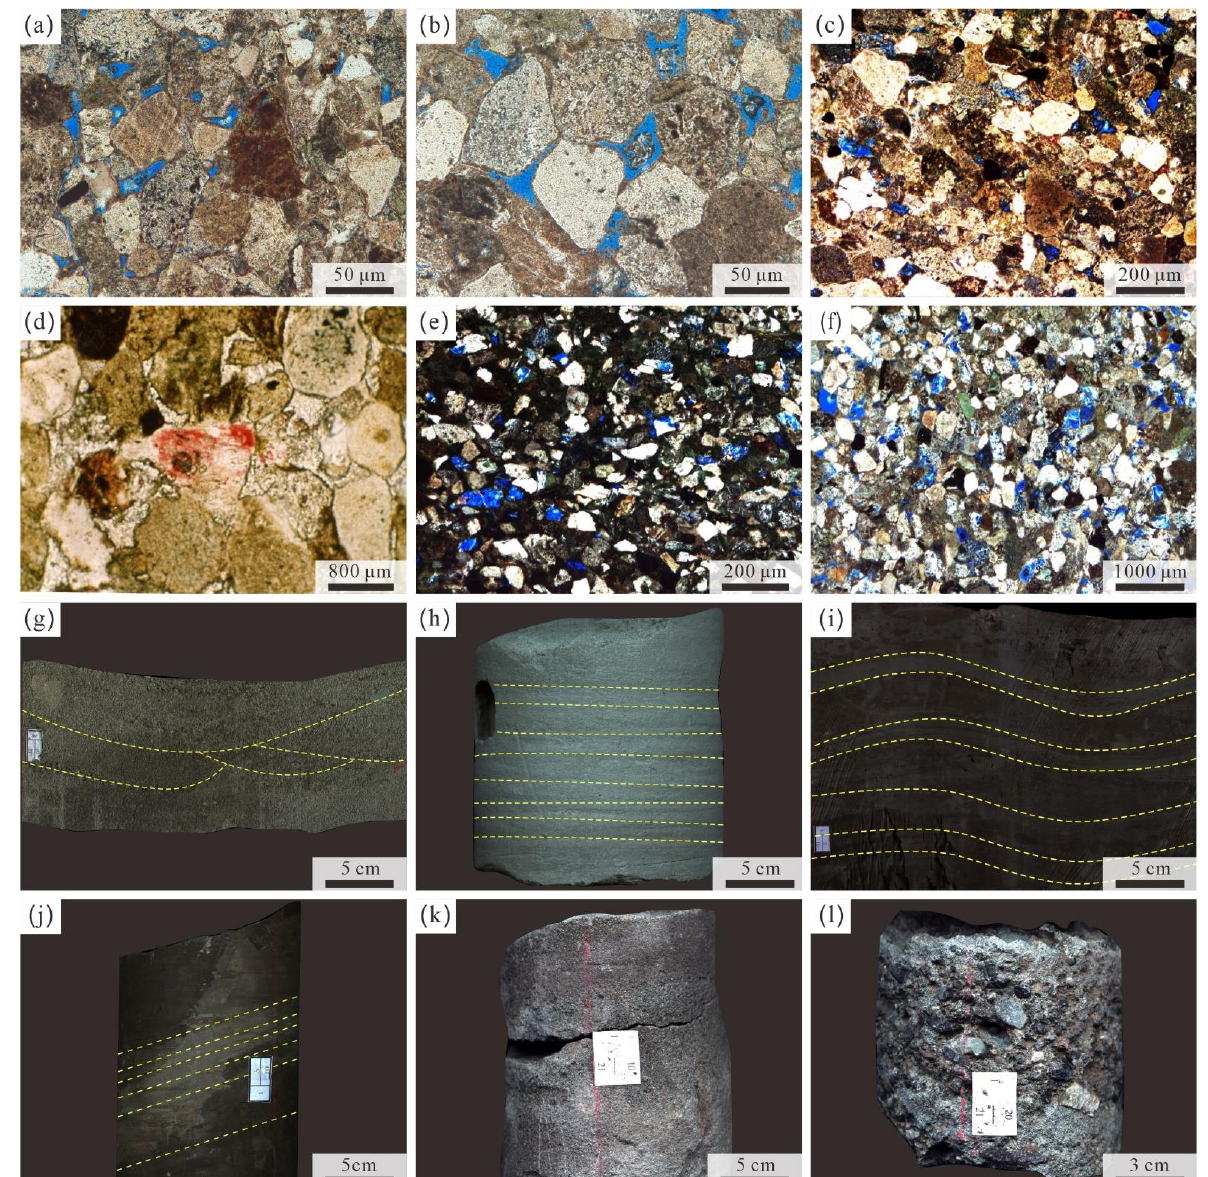
Figure 2. Rock characteristics of the Jiucaiyuan Formation in the Beisantai Uplift. ( a ) Well-sorted medium-grained sandstone with subangular particles; Drillcore SZ-2, 3415.88 m, Member II; PPL. ( b ) Gravelly medium-grained sandstone with medium sorting and subangular to subrounded par- ticles; Drillcore SZ-2, 3416.97 m, Member II; PPL. ( c ) Poorly-sorted medium-grained sandstone with subrounded particles; Drillcore GV-5, 2091.56 m, Member II; PPL. ( d ) Fine-grained sandstone with medium sorting and angular to subangular particles; Drillcore DB-2, 2372.70 m, Member II; PPL. ( e ) Well-sorted very fine-grained sandstone with subrounded particles; Drillcore EJ-6, 2600.35 m, Member I; PPL. ( f ) Well-sorted very fine-grained sandstone with subrounded particles; Drillcore EJ-6, 2600.68 m, Member I; PPL. ( g ) Brown sandstone with trough cross bedding; Drillcore NH-7, 2396.08–2396.16 m, Member II. ( h ) Gray-green sandstone with parallel cross bedding; Drillcore XS-5, 2292.81–2292.92 m, Member I. ( i ) Brown sandstone with wavy cross bedding; Drillcore HU- 3, 3730.67–3730.75 m, Member I. ( j ) Brown sandstone with trough cross bedding; Drillcore HU-3, 3731.39–3731.54 m, Member I. ( k ) Fine-grained sandstone with massive bedding; Drillcore GV- 5, 2091.71–2091.87 m, Member II. ( l ) Conglomerate with scour surface structure; Drillcore GV-5, 2092.18–2092.52 m, Member